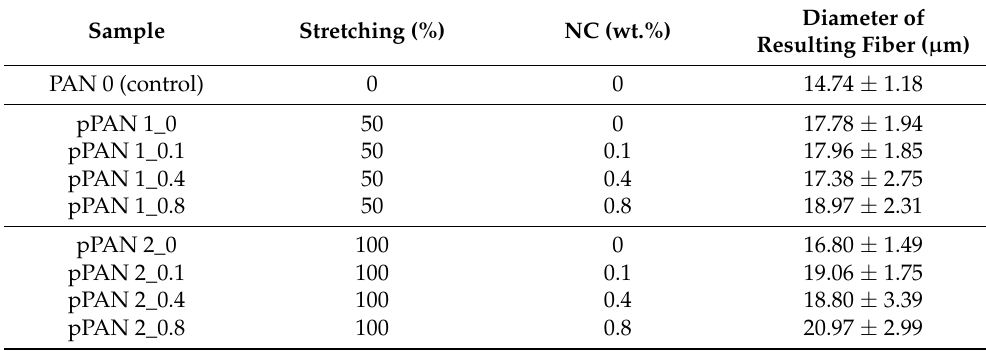
Diameter of Resulting Fiber ( µ m)